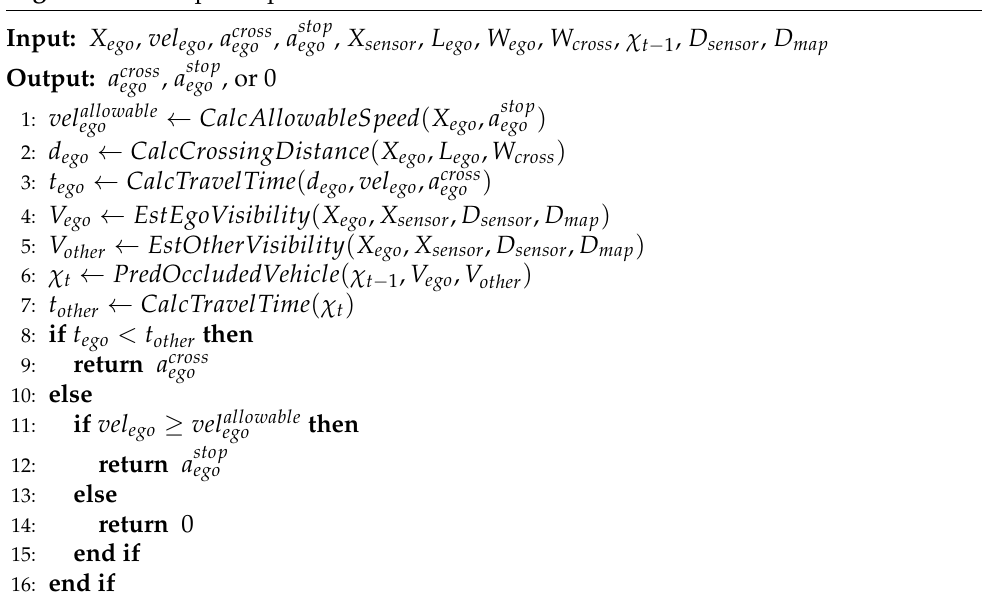
Algorithm 1. Proposed planner